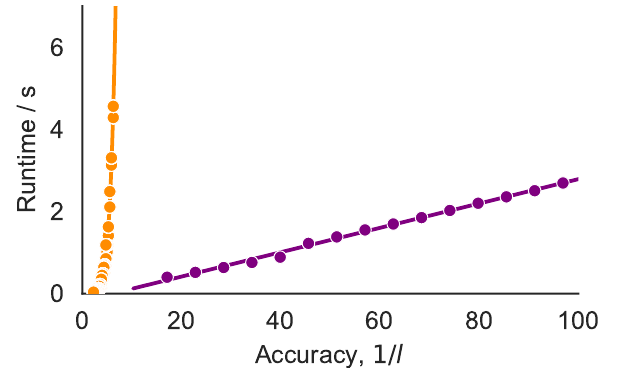
Figure 6. Test case (a). Orange: Discrete-only approach, polynomial trend line of order 6. Purple: Newton-Karush–Kuhn–Tucker (KKT) initialized with straight line, l ˆ = l C = δτ L , linear trend